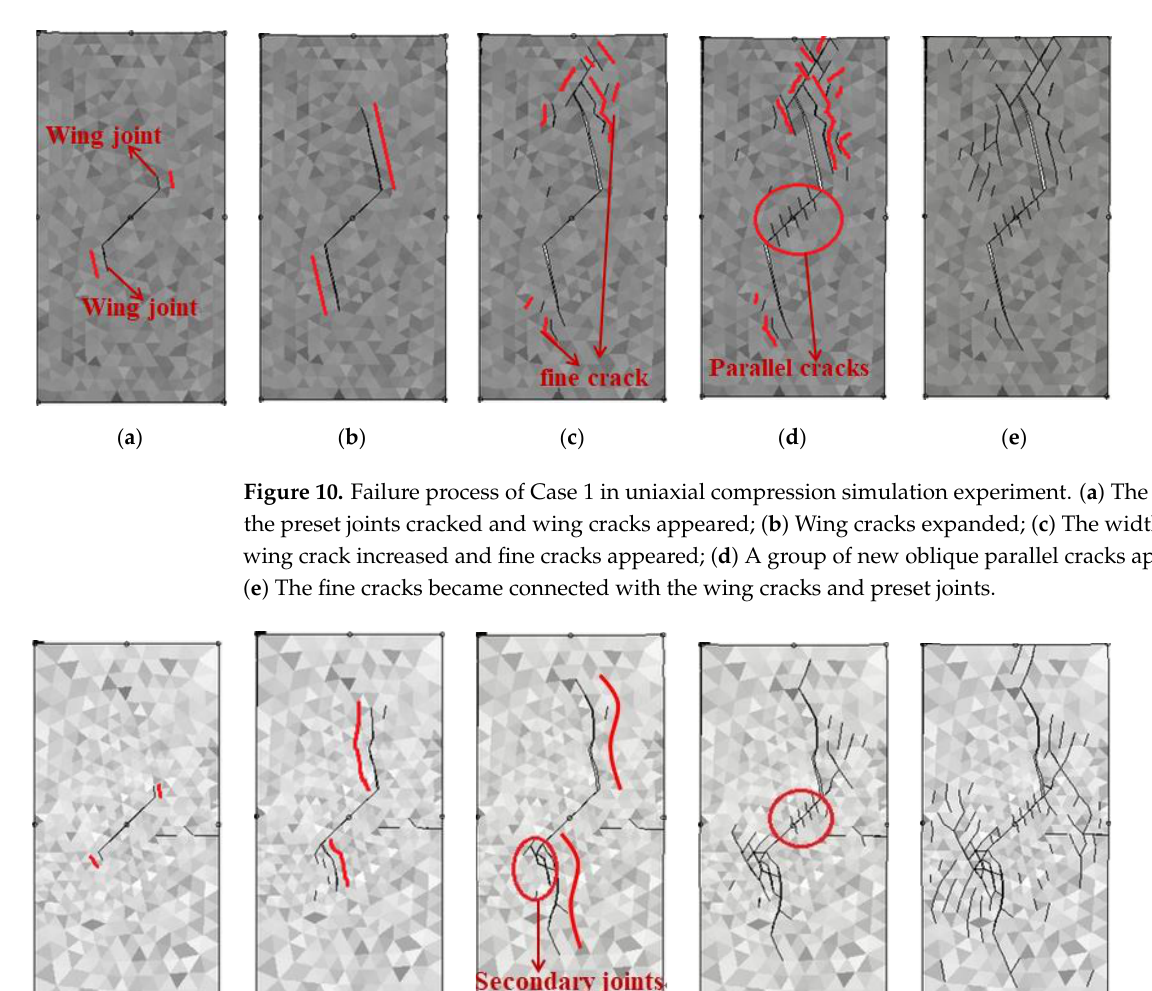
Figure 12. Failure process of Case 3 in uniaxial compression simulation experiment. ( a ) The ends of the preset joints cracked and wing cracks appeared; ( b ) Wing cracks expanded; ( c ) The width of the wing crack increased and fine cracks and some secondary joints appeared; ( d ) A group of new oblique parallel cracks appeared; ( e ) The fine cracks became connected with the wing cracks and preset joints.